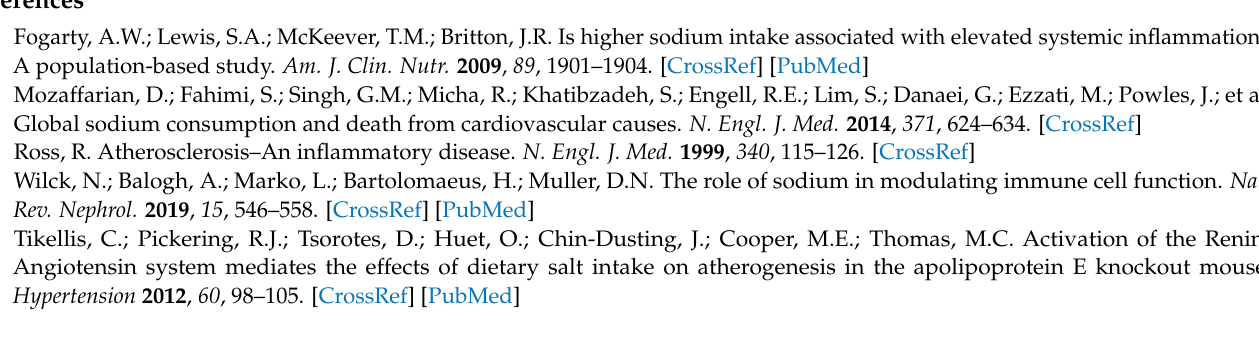
S2: Begg’s Funnel Plot for SPB and DBP, Figure S3: Meta-regression analysis for SBB and DBP and duration of the intervention, Table S1: PRISMA Checklist, Table S2: Assessment of risk of